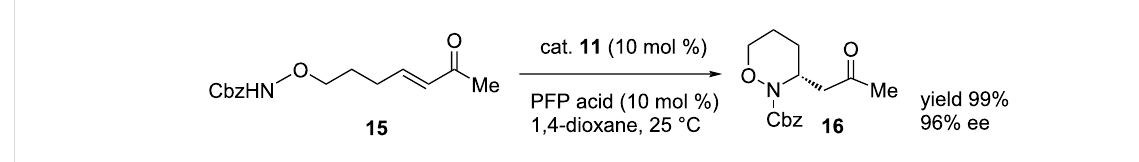
Scheme 2: Intramolecular 6- exo - trig aza-Michael addition reaction.